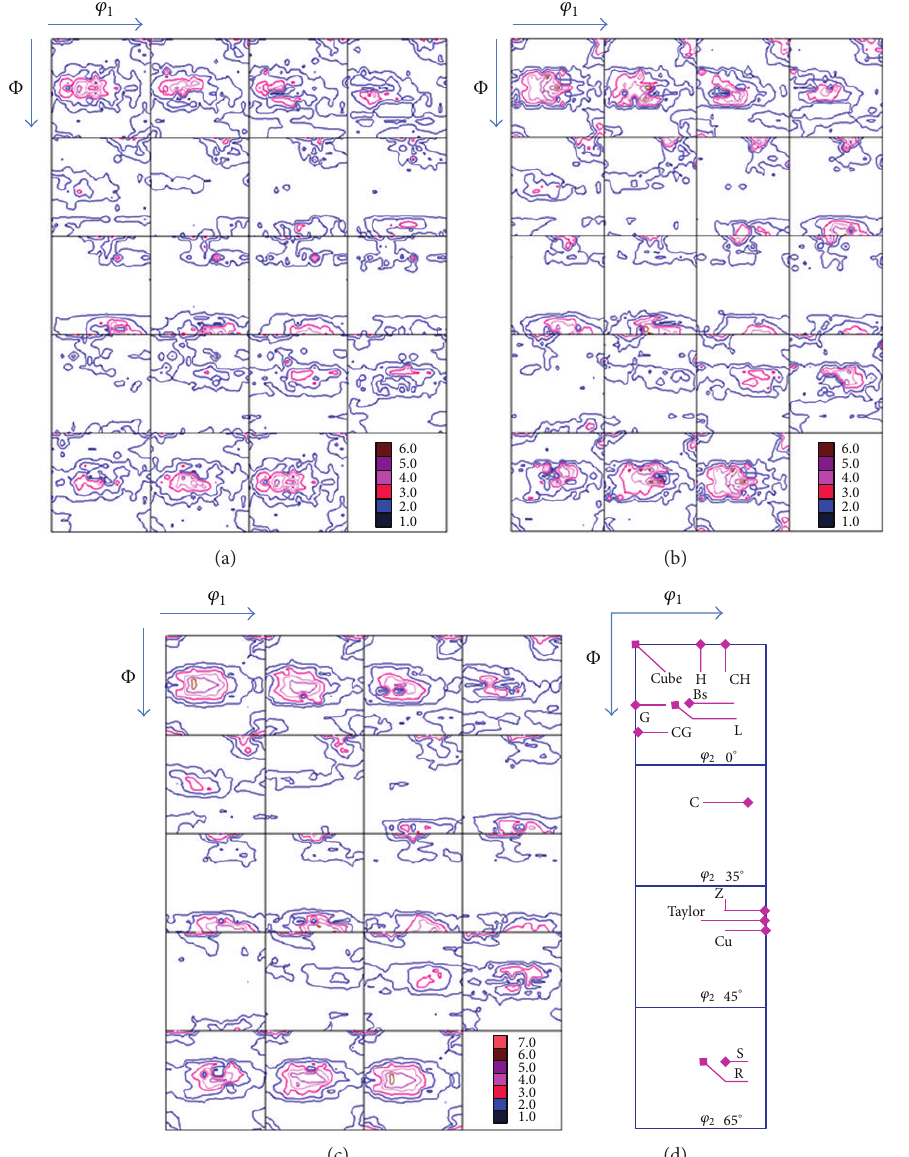
Figure 4: (a) Orientation distribution function (constant 𝜑 2 sections) of L1 sample. (b) Orientation distribution function (constant 𝜑 2 sections) of L2 sample. (c) Orientation distribution function (constant 𝜑 2 sections) of L3 sample. (d) Ideal orientation locations at constant ∘ , 35 ∘ , 45 ∘ , and 65 ∘ 𝜑 2 sections 0